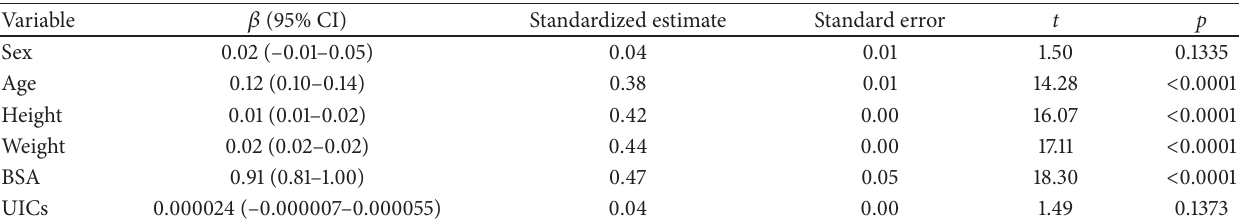
Table 2: Univariate regression for thyroid volume in log scale as a function of sex, age, height, weight, BSA, and UICs. Variable